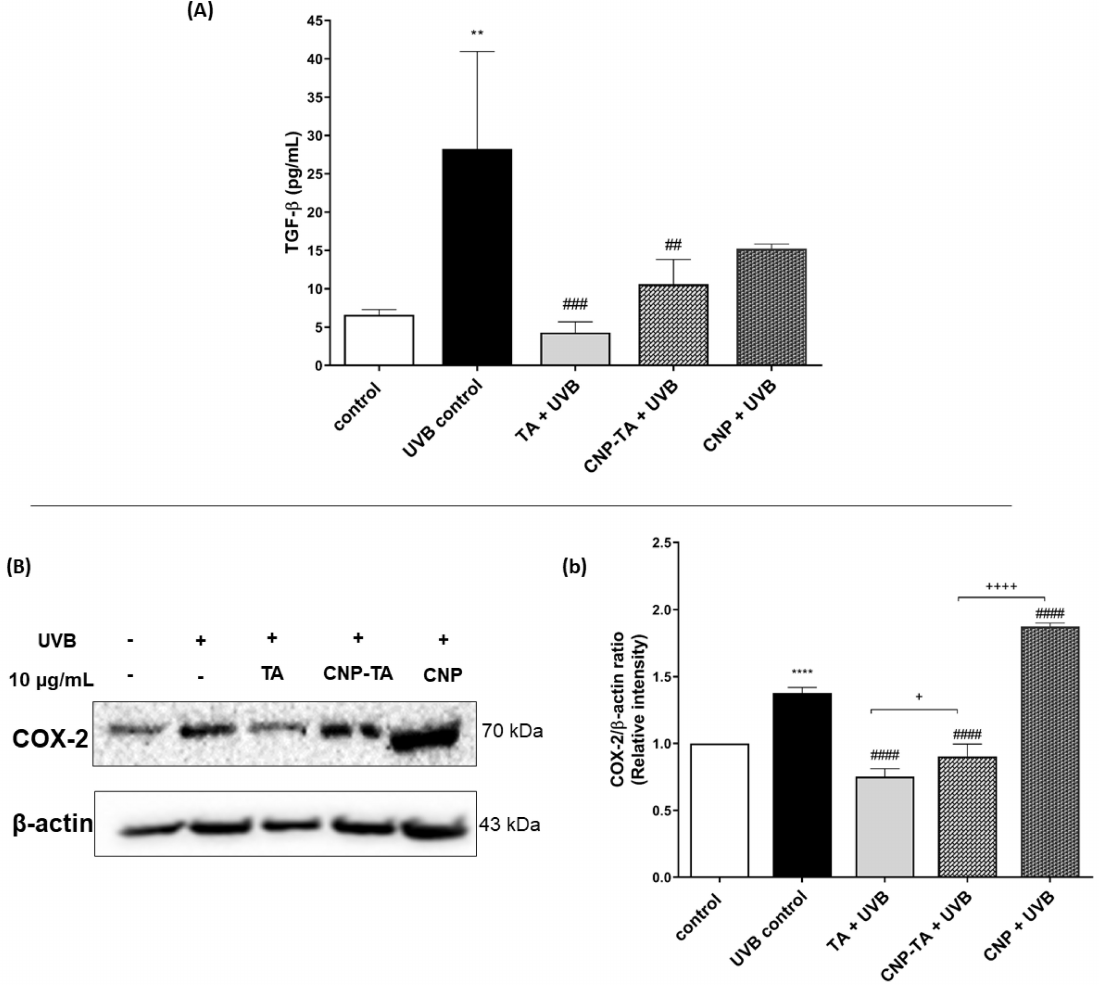
Figure 8. Effect of TA, CNP-TA and CNPs on the prevention of UVB-induced inflammation. ( A ) Effect of samples on the inhibition of transforming growth factor beta (TGF- β ) in treated (10 µ g/mL) and UVB-irradiated cells. ( B ; b )Effect of samples on cycloxygenase-2 (COX-2) protein expression in treated (10 µ g/mL) and UVB-irradiated cells. Protein levels were normalized with β -actin. ( B ) Protein bands were recorded using ChemiDoc ® XRS+ Imaging System; ( b ) Band quantification was measured using ChemiDoc ® software version 2.0. Control: non-irradiated and untreated cells; UVB control: irradiated and untreated cells. ** p < 0.01, **** p < 0.0001 compared to control, ## p < 0.01, ### p < 0.001 and #### p < 0.0001 compared to UVB control, + p < 0.05 and ++++ p <